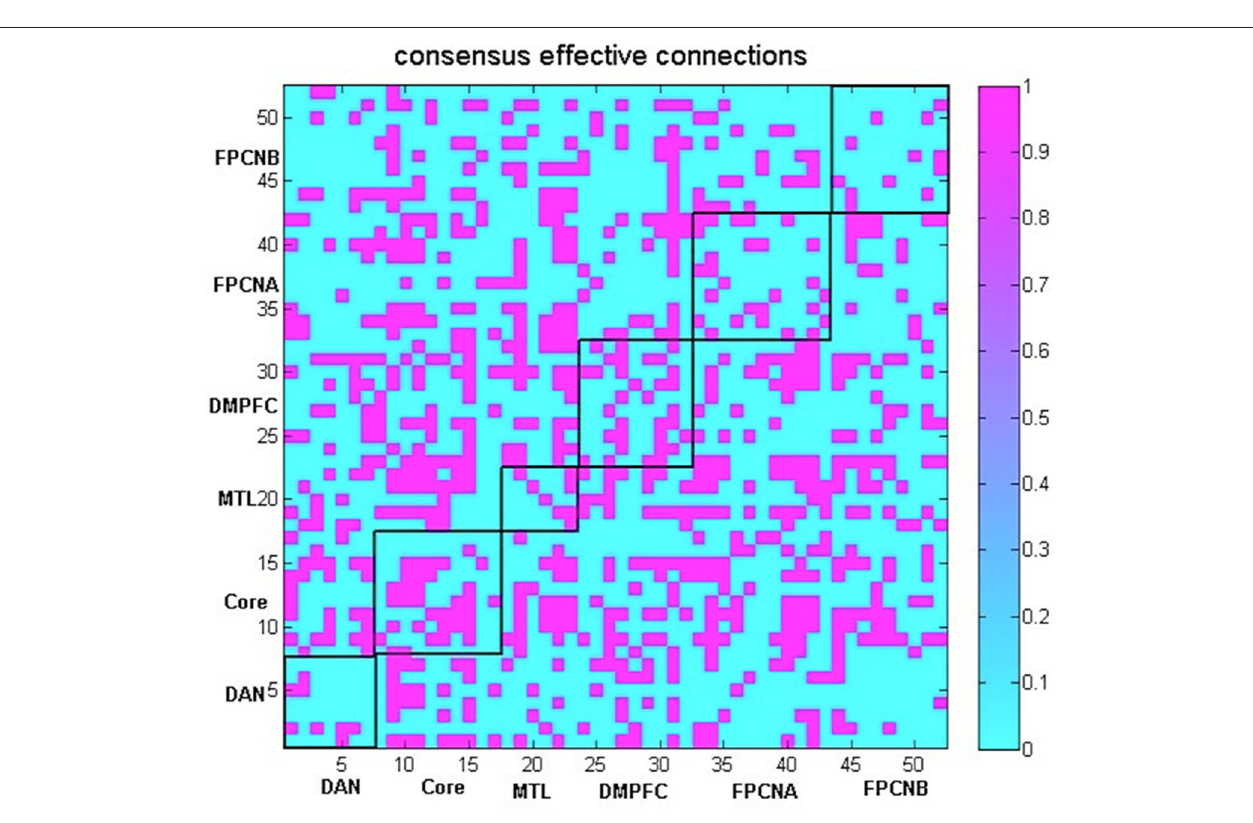
were performed, and the statistical significance level was set at p < 0.01 (the results at p < 0.02 were considered statistically significant at p < 0.05 after false discovery rate (FDR) correction for multiple comparisons). To further analyse the alterations